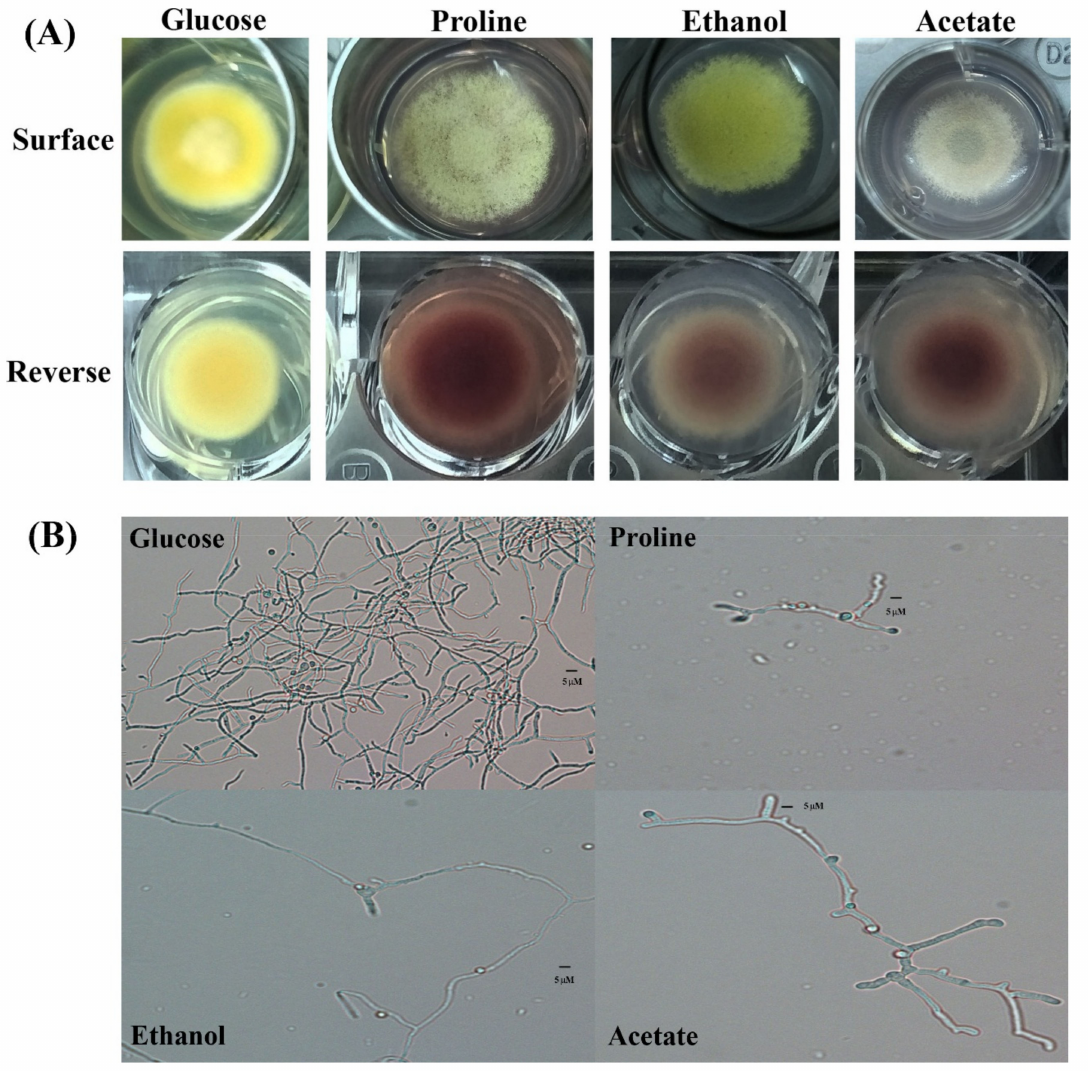
Figure 1. Mold-phase morphology of Talaromyces marne ff ei on gluconeogenic carbon sources. The carbon-free medium was supplemented with 1.0% glucose (preferential carbon source), 50 mM proline, 0.5% ethanol, or 50 mM sodium acetate as the sole carbon source. ( A ) Macroscopic mold colony morphology after incubation at 25 ◦ C for 12 days. Red pigment production is shown on the reverse side of the culture. ( B ) Microscopic morphology (magnification